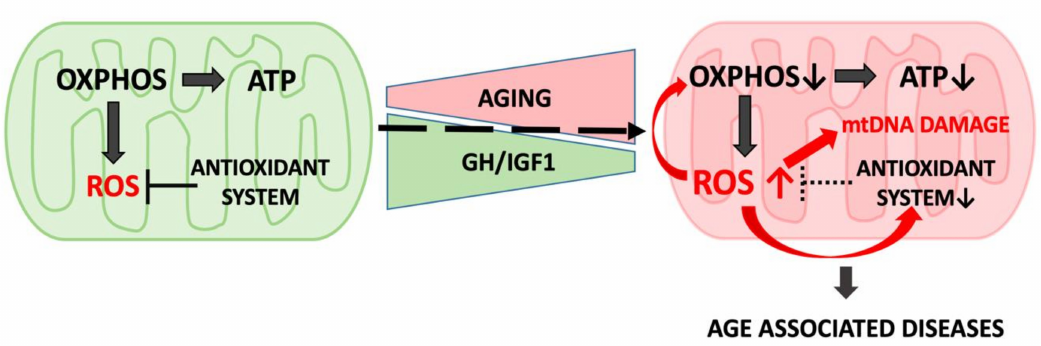
Figure 3. Mitochondria produce ATP and reactive oxygen species (ROS) as byproducts of oxidative phosphorylation (OXPHOS): In youth, ROSs are neutralized by the antioxidant system. Accumulation of proteins and enzymes damaged by escaped ROS leads to impairment of mitochondrial function during aging. Mitochondrial dysfunction is correlated with the decline in GH / IGF1 signaling and is linked to a variety of age-related